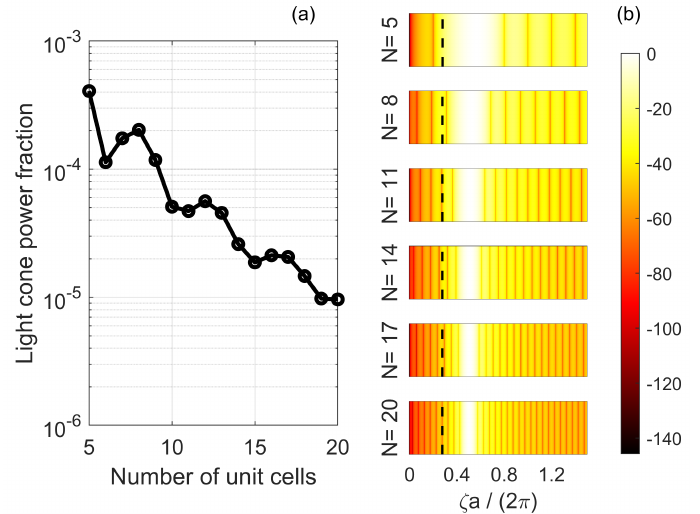
Figure 11. ( a ) Light cone power fraction as a function of the size of the cavity. ( b ) Squared magnitude of the electric field k -space distribution in dB normalized to its maximum for various LN cavities. The dashed, vertical line indicates the upper limit of the light cone for each